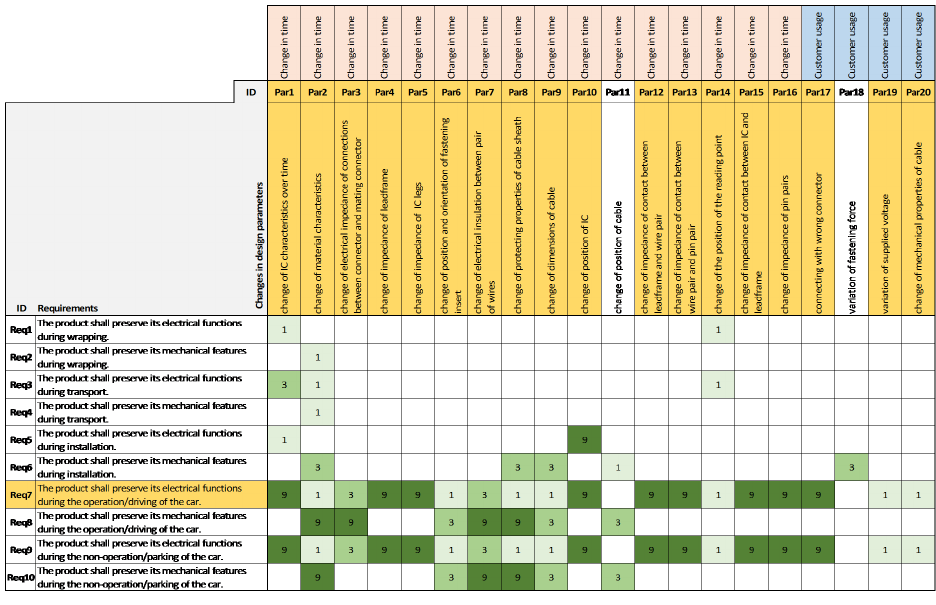
Figure 4. House of Design Parameters is the first House of Noises, which contains the requirements vs. changes in design parameters. The House of Design Parameters identify the direct causes, which result in the failure of the product. These direct causes are physical or chemical